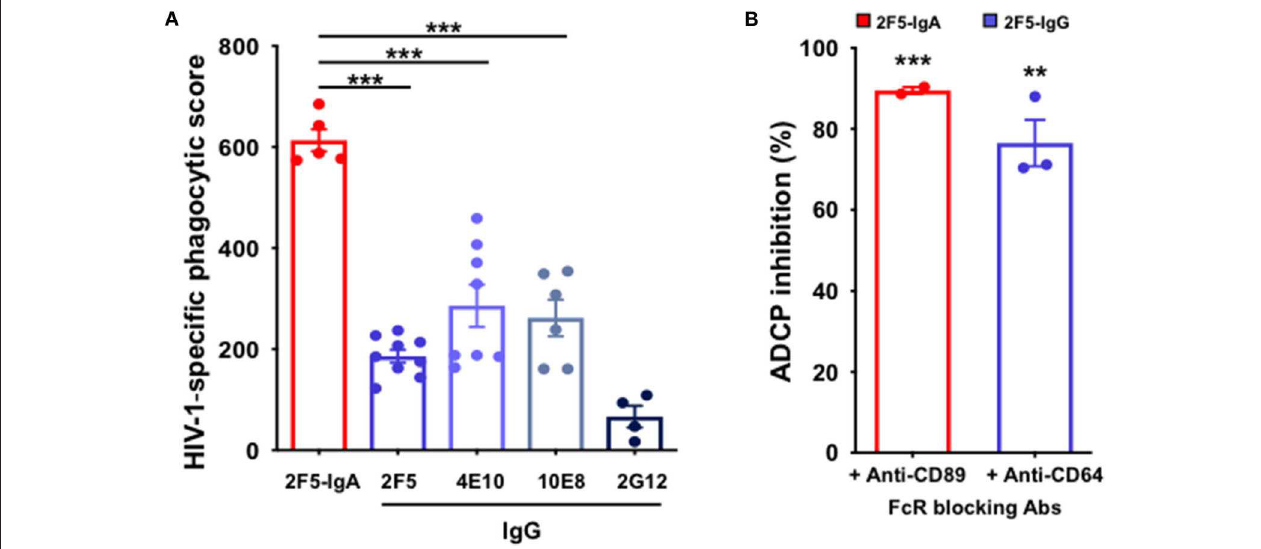
FIGURE 1 | Anti-gp41 2F5-IgA and gp41-specific IgG induce ADCP of P1-coated beads in a Fc α RI- and Fc α RI-dependent manner. (A) 2F5-IgA (red bar) and gp41-specific IgGs (blue bars) mediate phagocytosis of P1-coated beads: Fluorescent beads were coated with P1, pre-incubated with the antibodies for 30min at 37 ◦ C prior to addition to primary monocytes for phagocytosis for 3hrs at 37 ◦ C. gp120-specific 2G12-IgG (dark blue bar) or irrelevant human IgA2/IgG were used as negative controls. The P1-coated bead uptake was analyzed by flow cytometry and HIV-1 specific phagocytic score was calculated as indicated in the Method section. Values represent means of P1-specific phagocytic score obtained after the subtraction of the background phagocytosis levels induced by human IgA/hIgG ± SEM from 3 independent experiments performed in triplicate, *** p < 0.001, and, unpaired Student’s t -test. (B) ADCP depends on Fc α RI or Fc γ RI: Monocytes were pre-incubated with either anti-Fc α RI (CD89) or anti-Fc γ RI (CD64) blocking antibody for 30min at RT before addition to the immune complexes. Phagocytic score was calculated as in (A) . Values represent mean inhibition of phagocytic score in the presence of monocytes preincubated with anti-CD89 or anti-CD64 antibody ± SEM. ** p < 0.01, *** p < 0.001 unpaired Student’s t -test compared to ADCP in the absence of blocking